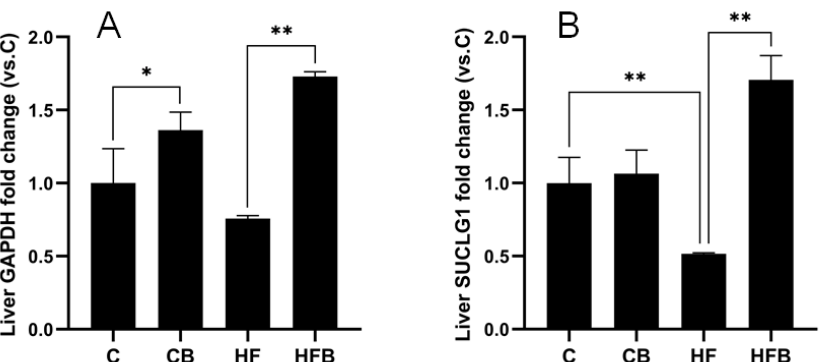
Figure 7. The expression of GAPDH ( A ) and SUCLG1 ( B ), as measured by MS protein profiling. The results are expressed as means ± SEM of the relative peak areas. * p < 0.05, ** p < 0.01.